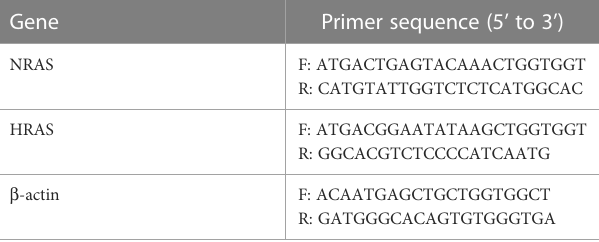
TABLE 1 Primer sequences of genes for qPCR. Gene Primer sequence (5 ’ to 3 ’